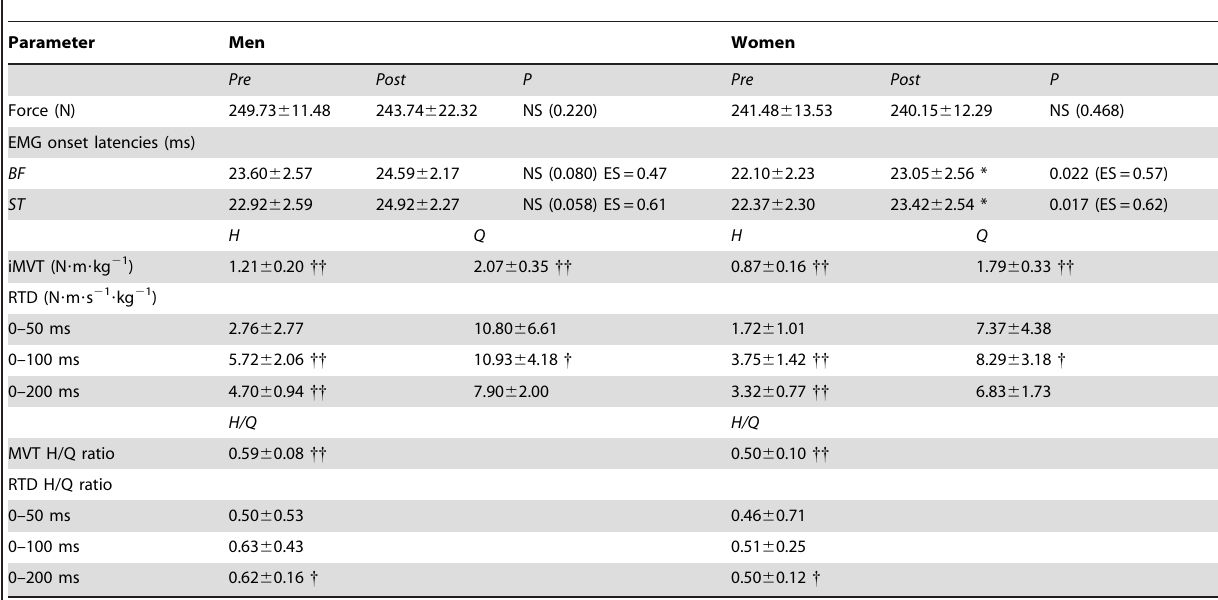
Table 1. Force applied to the proximal shank of the dominant leg and EMG onset latencies before and after the fatigue protocol for men and women. In addition, weight-normalized isometric maximum voluntary torque (iMVT), weight-normalized rate of torque development (RTD 0–50, 0–100, 0–200 ) of the hamstrings (H) and quadriceps (Q), MVT H/Q ratio and RTD H/Q ratios (RTD 0–50, 0–100, 0–200 H/Q) for men and